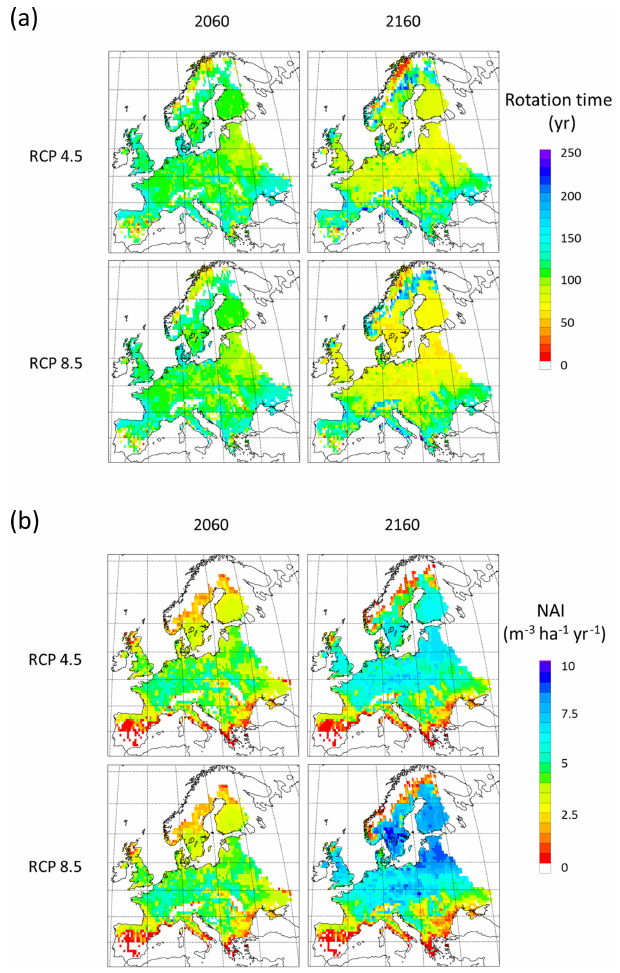
Figure E8. Simulations of broadleaf forests using automated thin- ning and clear-cutting under RCP 4.5 and RCP 8.5 CO 2 and cli- mate, recycling the last 30 climate data years after 2100. (a) Mean rotation time for the latest clear-cut events in each stand in 2060 and 2160. (b) Mean net annual increment (NAI) during the latest rotations in each stand in 2060 and 2160. For the expansion from total vegetation carbon to wood volume, a wood volume/vegetation carbon ratio of 3.3m 3 tC − 1 was used.